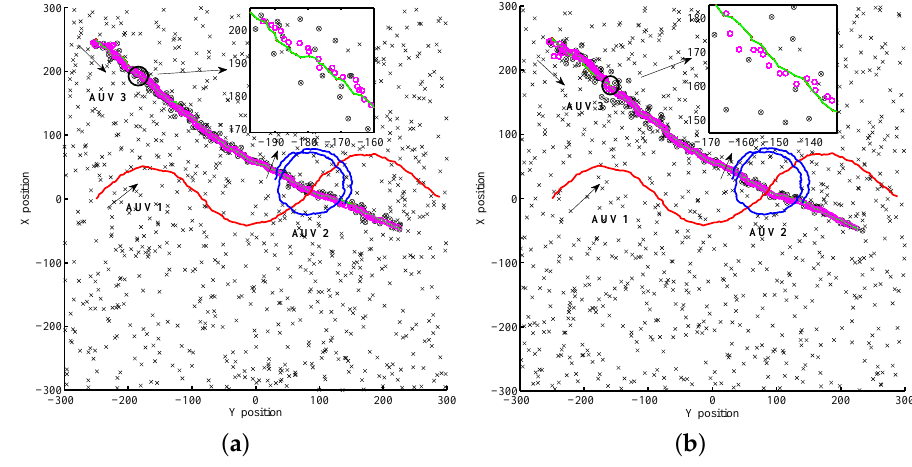
Figure 11. Trajectories, clutter and measurements in Scenario 2. ( a ) Result with respect to AUV 1 only; ( b ) Result with respect to AUV 2 only.